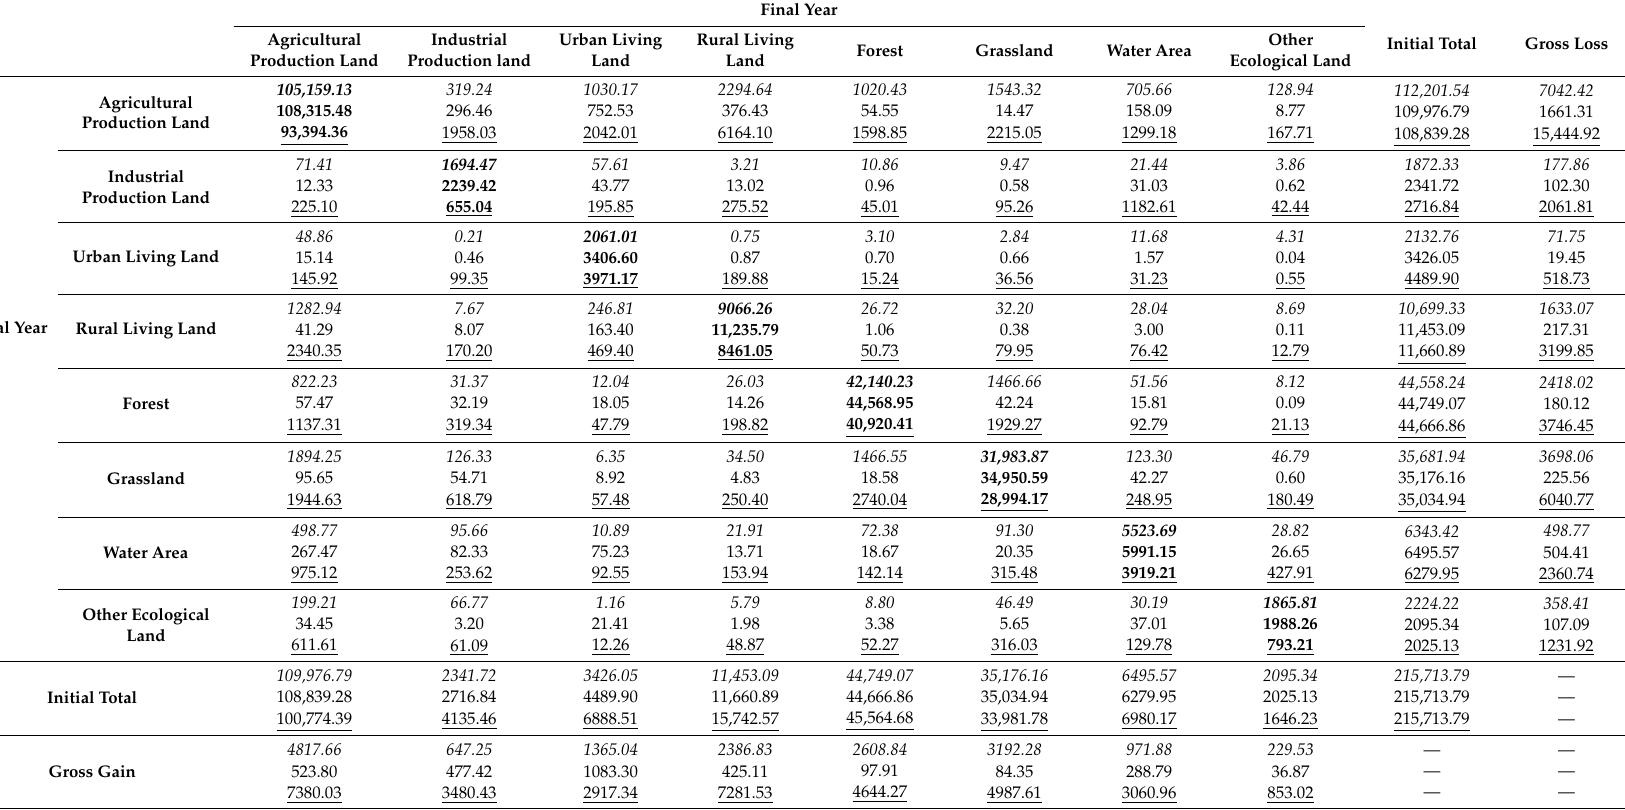
Table 3. Land use transfer matrix from 1985 to 2018 (km 2